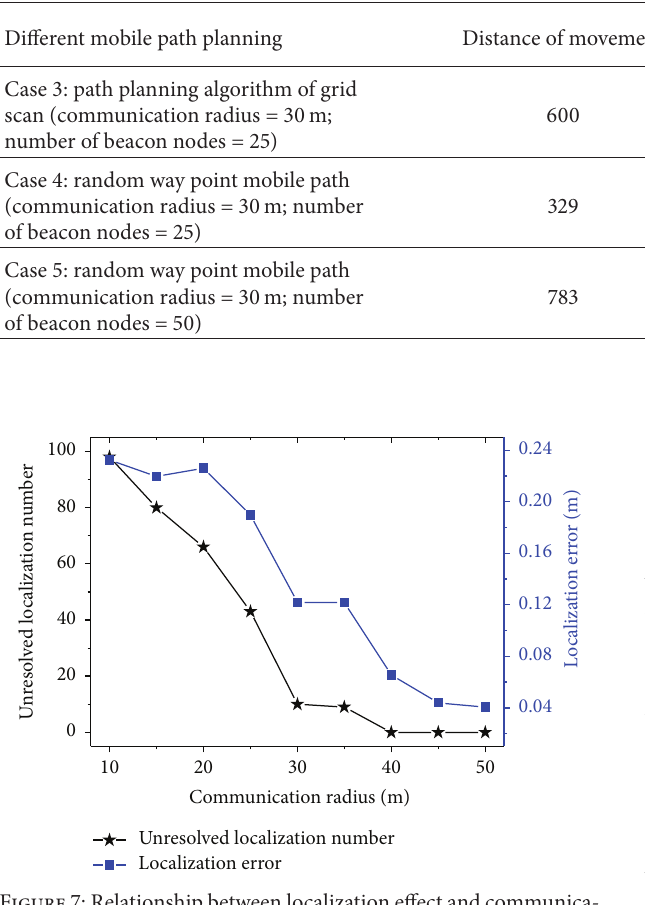
Table 2: Contrast of difference mobile paths.